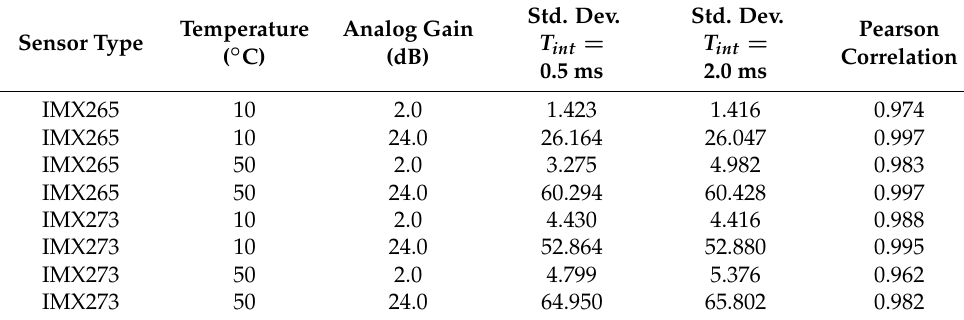
Table 1. DSNU standard deviations and Pearson